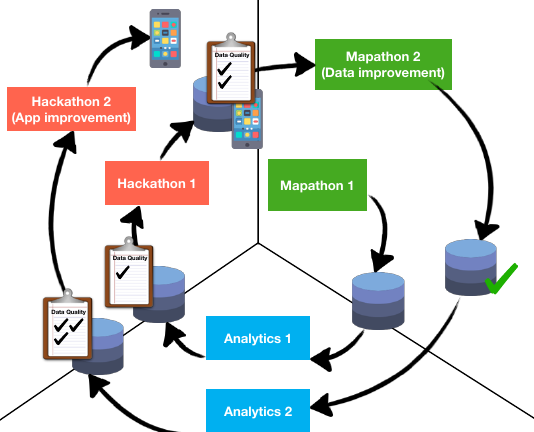
Figure 1. Circular process for collecting geospatial data in